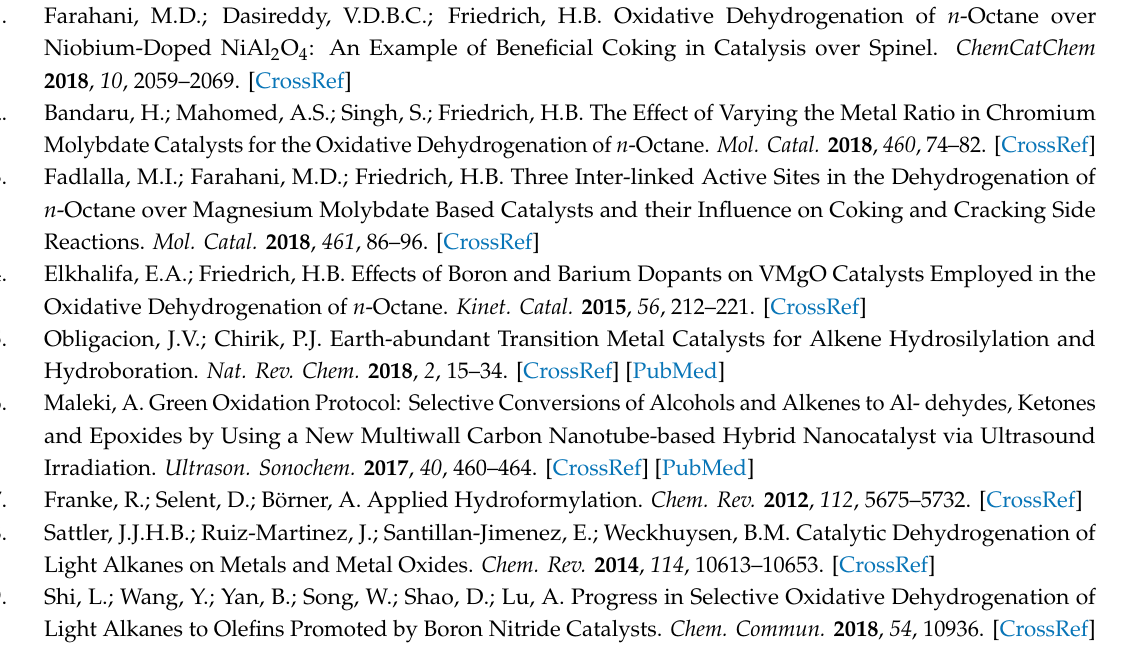
Figure S1: SEM micrographs of ( A ) NaY, ( B ) Ga-NaY, ( C ) 0.02BaGa-NaY, ( D ) MgGa-NaY, ( E ) CaGa-NaY, ( F ) SrGa-NaY, ( G ) BaGa-NaY, ( H ) 0.08BaGa-NaY; Figure S2: SEM-EDX micrographs of ( A ) 0.02BaGa-NaY, ( B ) BaGa-NaY, ( C ) 0.08BaGa-NaY; Figure S3: NH3-TPD Profiles of ( A ) NaY, ( B ) Ga-NaY, ( C ) MgGa-NaY, ( D ) SrGa-NaY, ( E ) BaGa-NaY, ( F ) CaGa-NaY; Table S1: Temperature programmed reduction results for the Ga-NaY